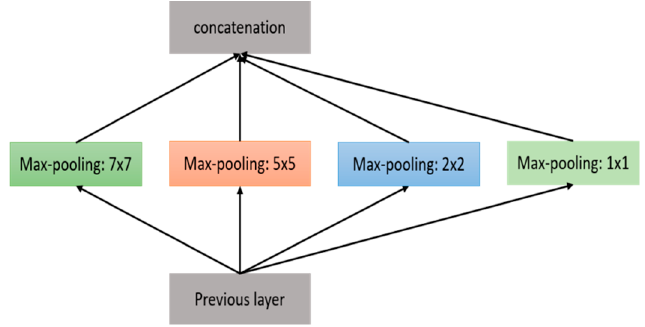
Figure 26. Spatial pyramid pooling.